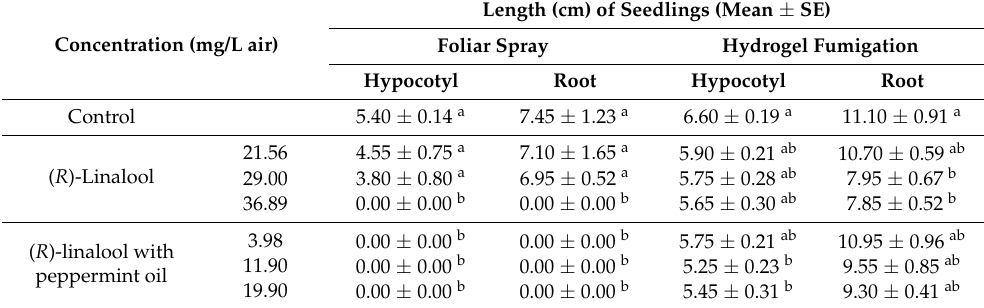
Table 4. Phytotoxicity of ( R )-linalool and peppermint oil applied as foliar spray or hydrogel fumiga- tion to S. lycopersicum ( n =